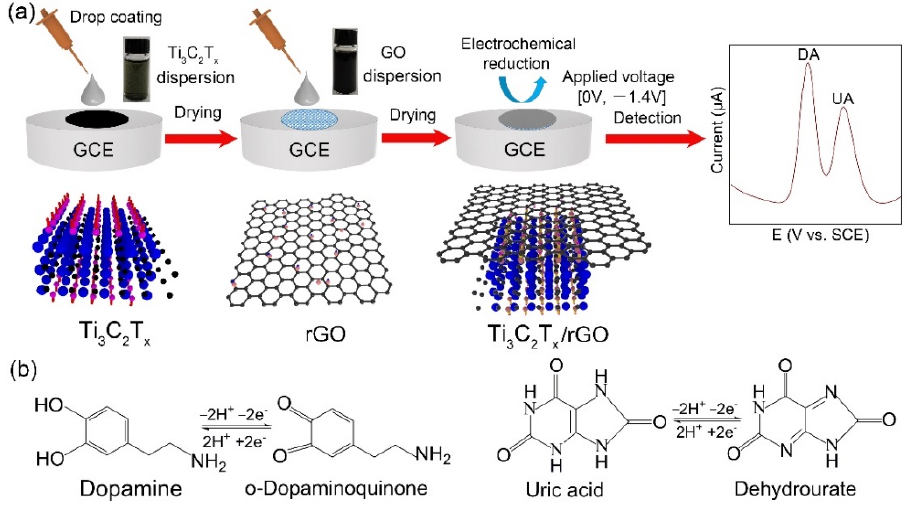
Figure 1. ( a ) Schematic diagram of electrochemical detection of DA and UA based on Ti 3 C 2 T x /rGO electrode. ( b ) The proposed reaction scheme of redox reaction of DA and UA during electrochemical detection, respectively.